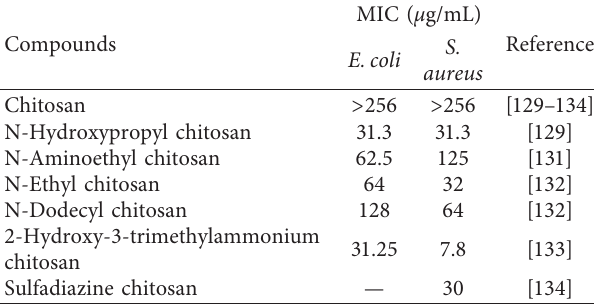
Table 2: MIC ( μ g/mL) of chitosan and its derivatives against E. coli and S. aureus